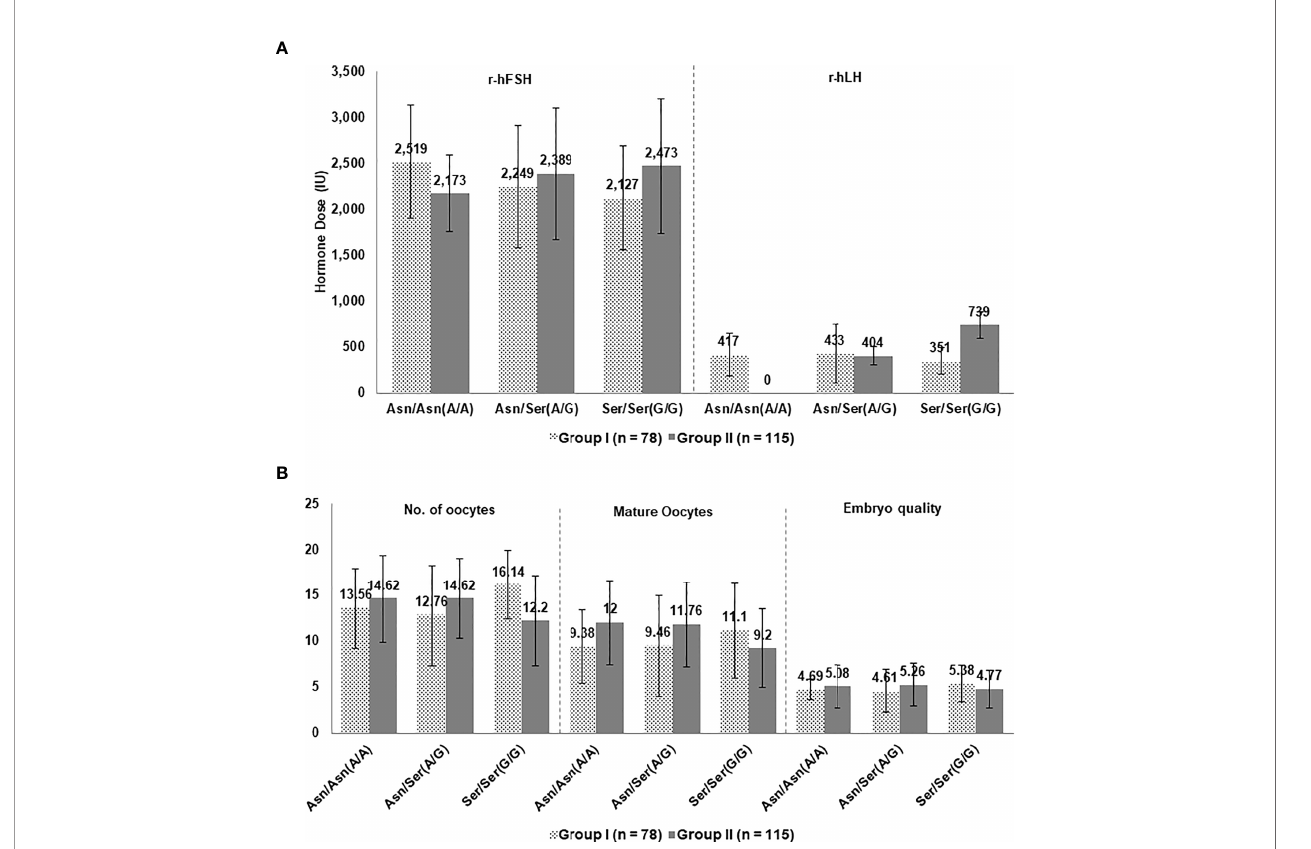
FIGURE 2 | (A) Hormone supplementation and (B) Embryology parameters for patients in Groups I and II in the second cycle based on LHCGR (Asn312Ser)